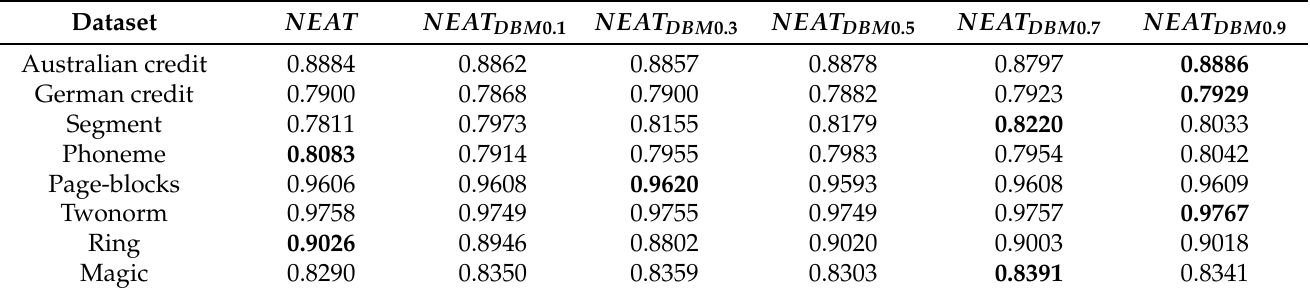
Table 3. Sensitivity analysis of NEAT-DBM compared to NEAT, training set.